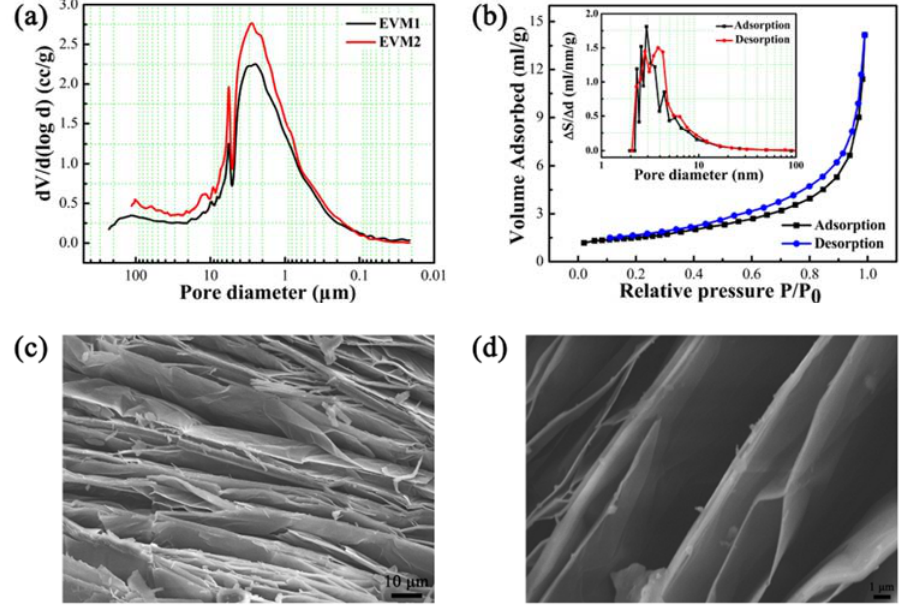
Figure 3. Characterization of EVM pore structures: ( a ) pore diameter distribution determined by mercury intrusion porosimetry (EVM1 and EVM2 represent the first and second measurement result, respectively); ( b ) nitrogen adsorption-desorption isotherms and the corresponding pore-size distribution curve (inset); and ( c , d ) SEM images of EVM ( × 1.0 k and × 5.0 k).